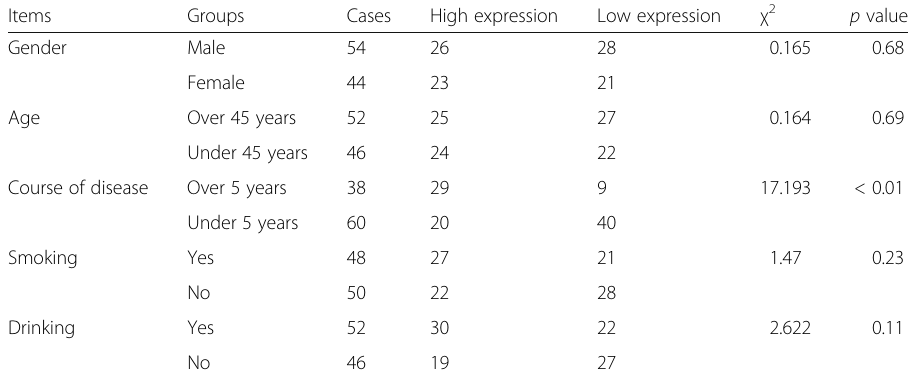
Table 1 Correlation between the serum levels of lncRNA-ATB and clinical data for osteoarthritis patients Items Groups